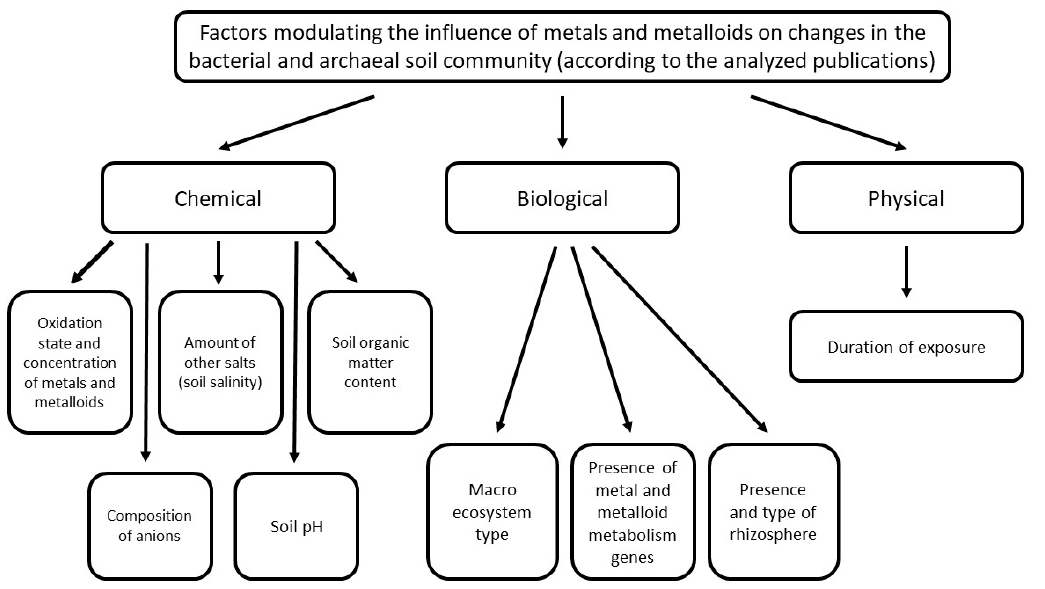
Figure 2. Factors modulating the influence of metals and metalloids on changes in the bacterial and archaeal community (according to the analyzed publications).